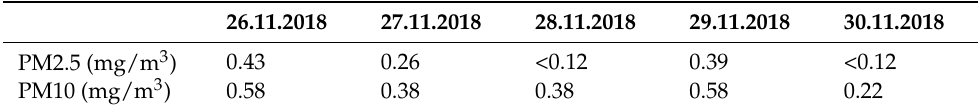
Table 3. Results from the gravimetric measurements in